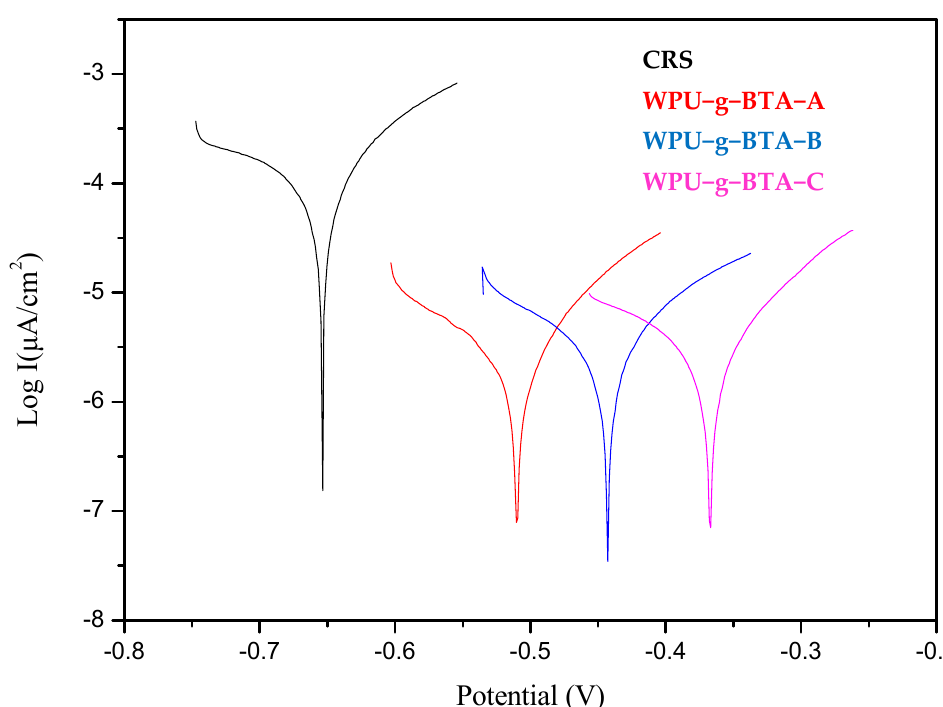
Figure 4. Tafel plots for raw CRS electrode and CRS electrode coated with WPU − g − BTA − A, WPU − g − BTA − B, and WPU − g − BTA − C in 3.5 wt% NaCl (aq) for 3 days of immersion. Table 3. Long term anti-corrosion study for raw CRS and CRS electrode coated with WPU-g-BTA-A, WPU-g-BTA-B, and WPU-g-BTA-C in 3.5 wt% NaCl (aq) at 298 K. Sample